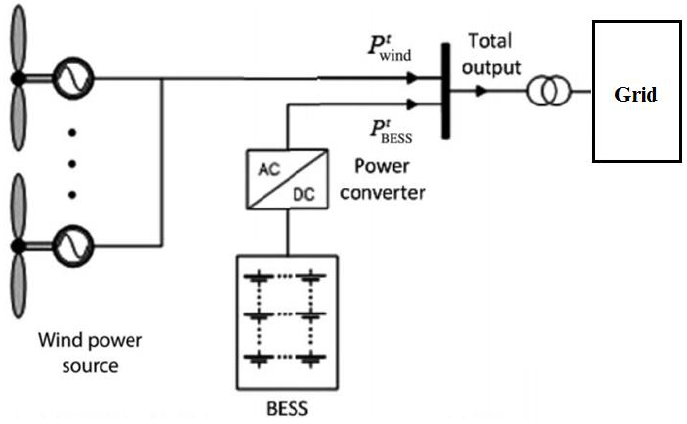
Figure 7. Battery energy storage system (BESS) for smoothing wind output connected to the grid. Reprint with permission [70]; Copyright 2016, IEEE.